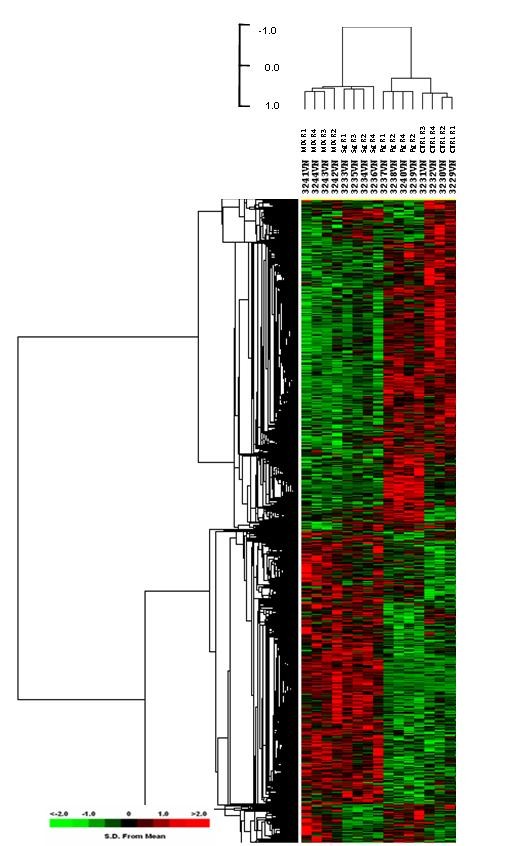
HIGK Gene expression upon P. gingivalis and S. gordonii single- and mixed infections. Hierarchical clustering was performed on variance-normalized signal of gene expression data from uninfected HIGK cells (CTRL) and from cells in co-culture with either organism or a mixture of both for 2 h before RNA isolation and purification. Probe set signal intensities were variance-normalized, mean-centered across samples, and subjected to hierarchical cluster analysis. Heat map and dendrogram were constructed from 6066 probe sets that were differentially expressed among the treatment conditions at a level of significance of p < 0.05. The degree of similarity between the transcriptional profiles of each sample is expressed by Pearson's correlation coefficient distance metric, according to the adjacent scale. The expression state of each data point is represented as standard deviations from the mean expression level for that gene in all samples. Red indicates a relative increase, green indicates a relative decrease, and black indicates no relative change of mRNA transcripts for a given gene.